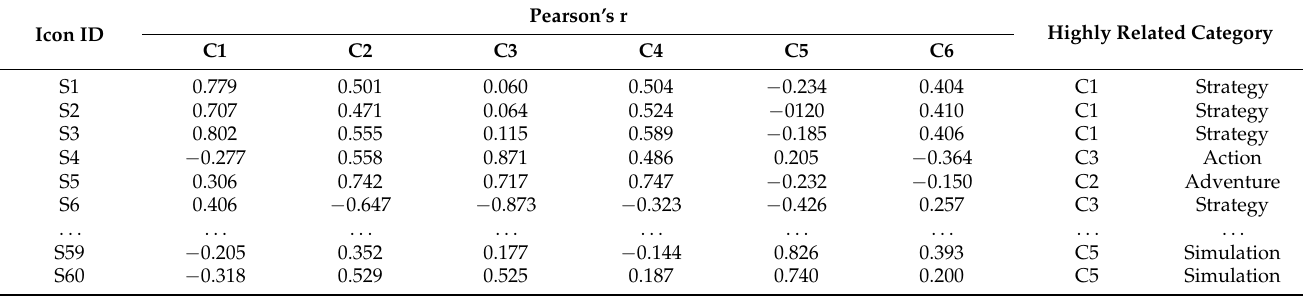
Table 6. Pearson’s r value obtained from correlation